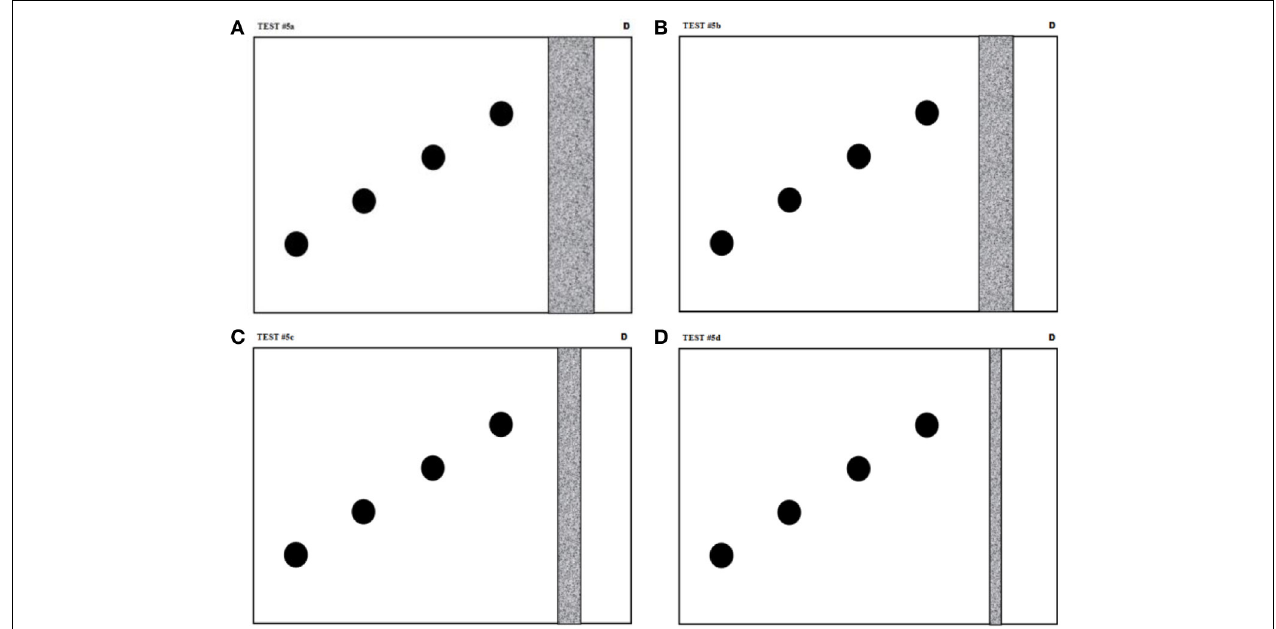
FIGURE 5 | Guiding sheets for the speed/accuracy trade-off task. The black circles and the gray areas indicate respectively the starting and the target zones. The distance between the centers of the starting and the target zones are 45, 90, 135, and 180mm and the width of the target zones are (A)